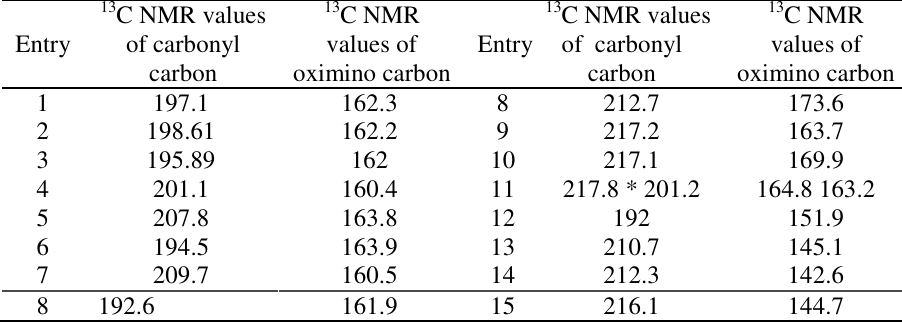
Table 2 . 13 C{ 1 H} NMR chemical shifts of